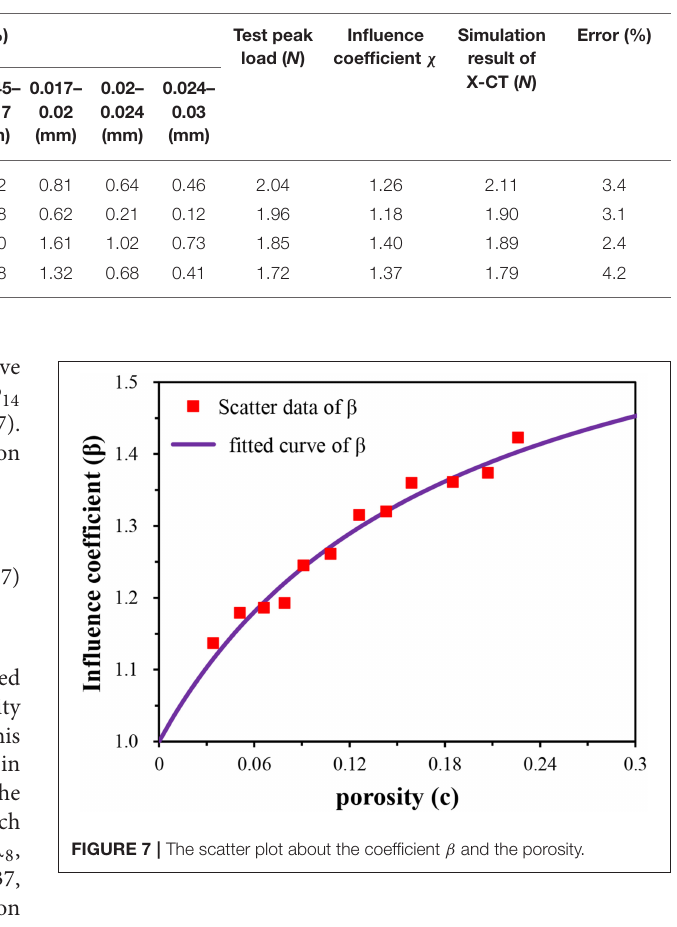
TABLE 4 | Simulation result after considering the pores influence. Indentation point